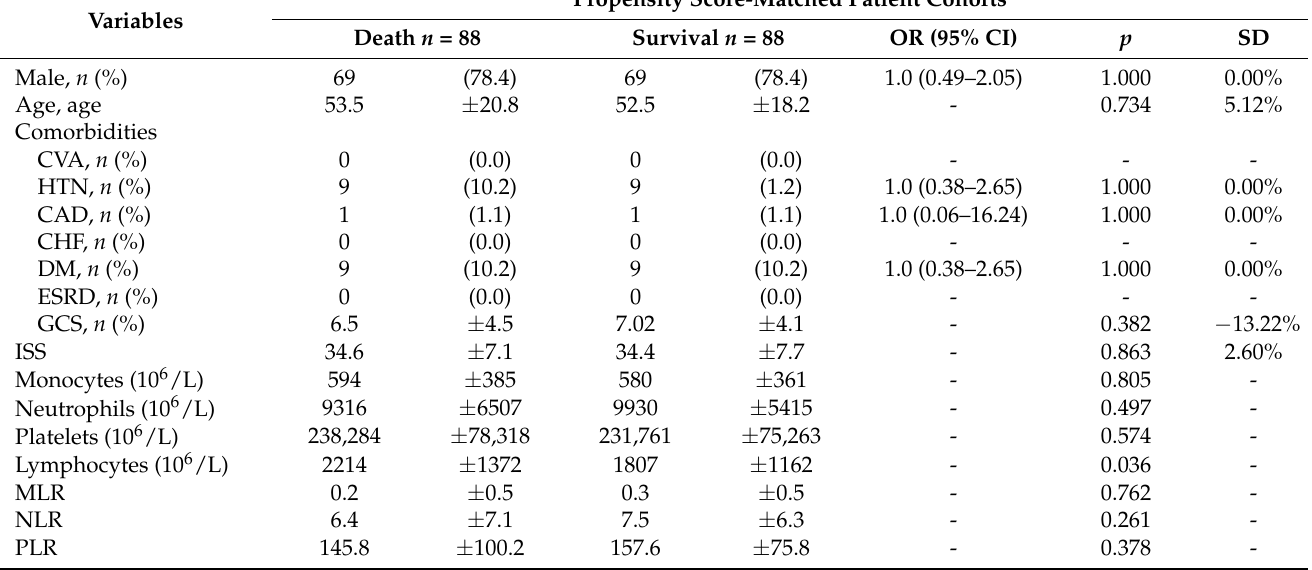
Table 2. Comparison of the neutrophil-to-lymphocyte ratio, monocyte-to-lymphocyte ratio, platelet- to-lymphocyte ratio, and subtypes of white blood cells in propensity score-matched cohorts of patients with polytrauma.